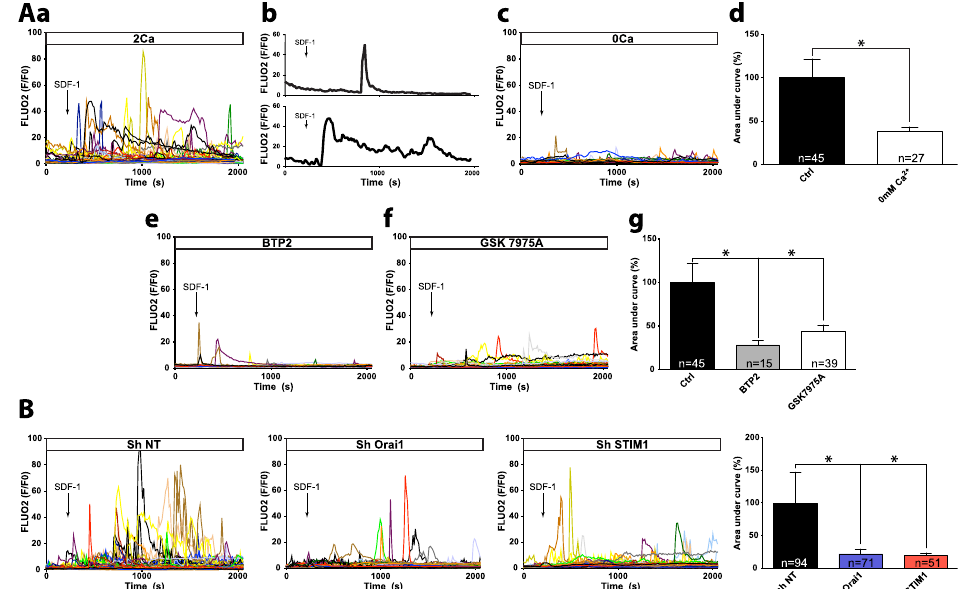
Figure 1. Stromal Derived Factor 1 (SDF-1) provokes an intracellular Ca 2+ response in the HLY-1 diffuse large B cell lymphoma (DLBCL) cell line involving intracellular Ca 2+ pool mobilization and Orai1/STIM1 extracellular Ca 2+ influx. Ca 2+ responses to SDF-1 (100 ng/mL) were measured using Fluo2-LR-AM Ca 2+ dye and recorded by videomicroscopy (Zeiss LSM 510) using × 25 objective. Black arrows indicate SDF-1 addition. Each trace represents the response of one cell and data are representative of at least three independent experiments. Typical response of unique cell (peak or peak follow by sustained plateau phase) are present as example ( Ab ). Data were processed using GraphPad prism. ( A ) Pharmacological characterization of SDF-1-induced Ca 2+ increase. Cells were recorded in extracellular saline solution